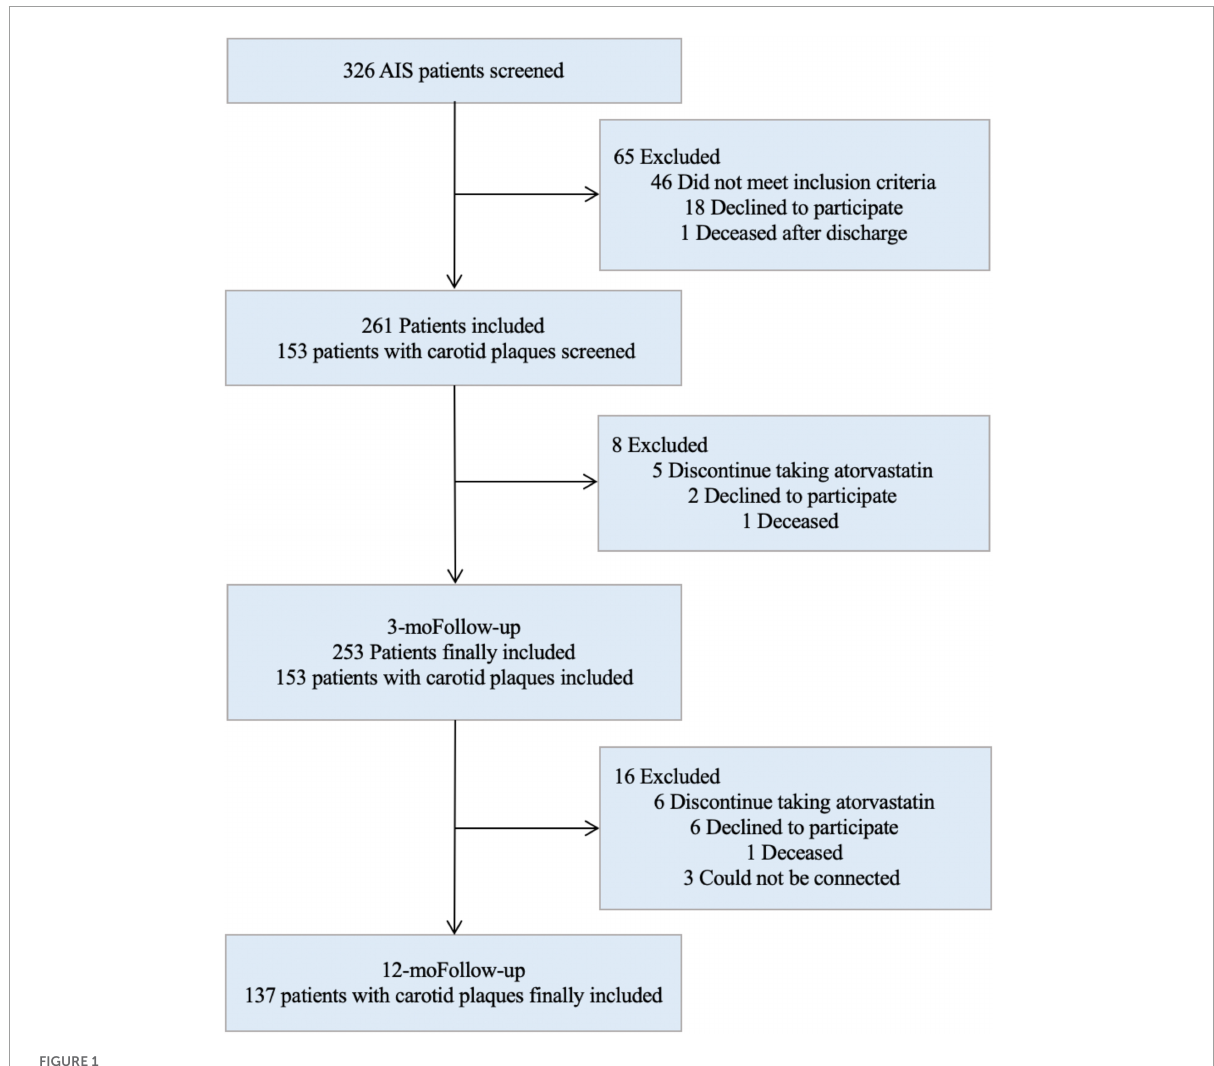
FIGURE1 Screening flowchart.